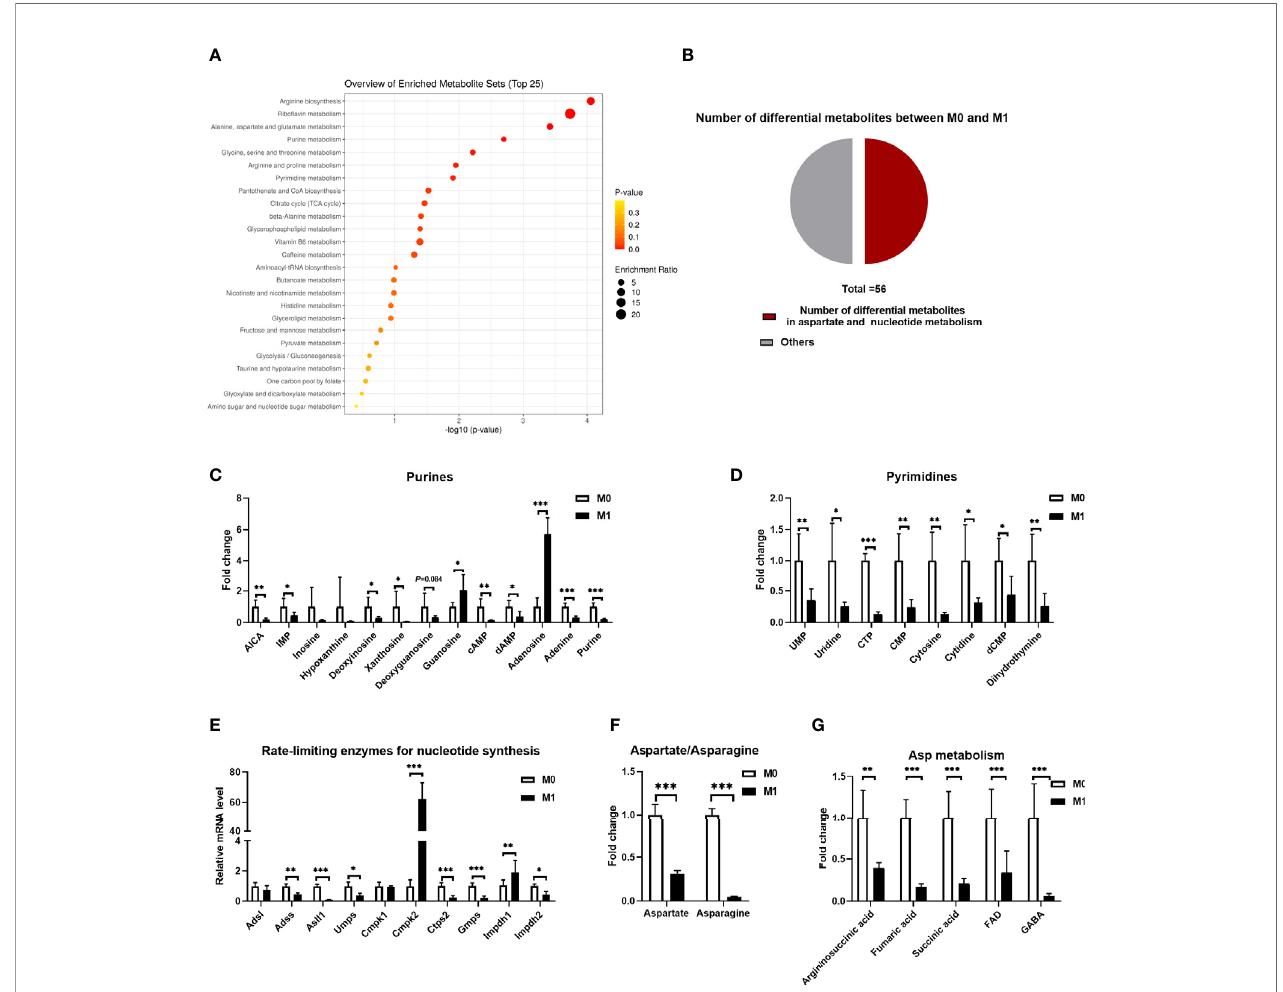
FIGURE 1 | M1 macrophages show altered aspartate metabolism. (A) Kyoto Encyclopedia of Genes and Genomes (KEGG) annotation and enrichment of differential metabolites between unstimulated (M0) and lipopolysaccharide (LPS)/interferon gamma (IFN- g )-stimulated (M1) macrophages ( n = 6). (B) Pie chart of the different metabolites between M0 and M1 macrophages ( n = 6). (C, D) Fold change of intracellular purine (C) and pyrimidine (D) between M0 and M1 macrophages ( n = 6). (E) mRNA expressions of rate-limiting enzymes for nucleoside synthesis between M0 and M1 macrophages ( n = 6). (F) Fold change of intracellular aspartate and asparagine between M0 and M1 macrophages ( n = 6). (G) Fold change of intracellular metabolites for aspartate synthesis between M0 and M1 macrophages ( n = 6). Data in (A – D) and (F, G) were adapted from Figure 3A of our previous study (27). All data were analyzed with unpaired t -test. Error bars represent the mean ± SEM. * p ≤ 0.05, ** p ≤ 0.01, *** p ≤